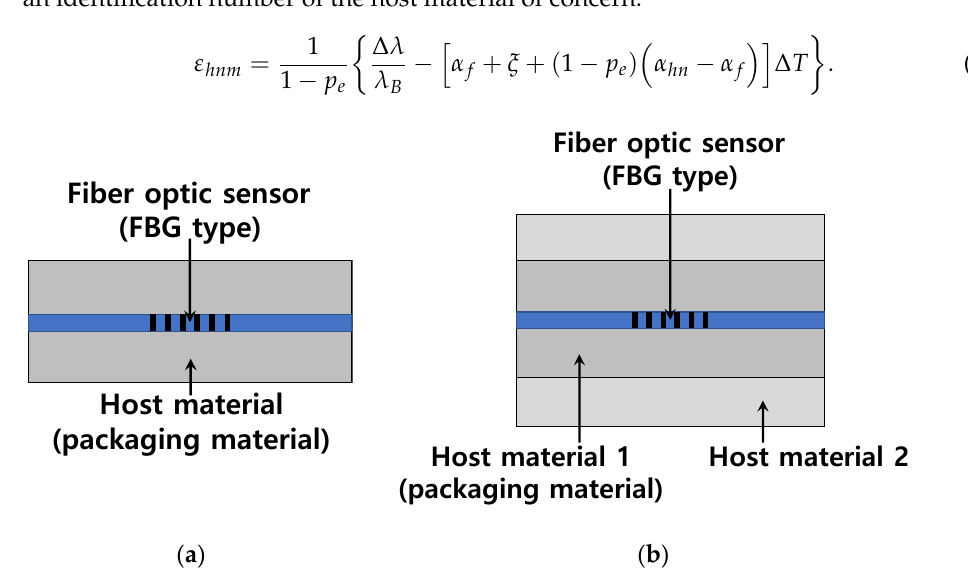
Figure 2. FBG embedded in host materials: ( a ) one host material; and ( b ) two host materials.